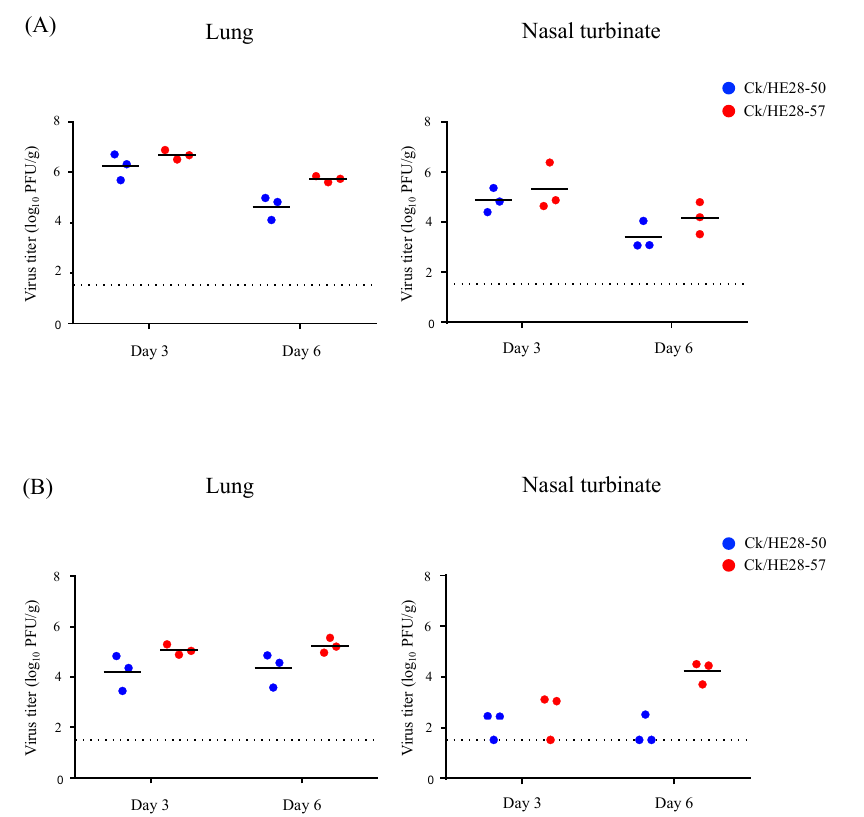
Figure 2. Virus titers in mice infected with H9N2 avian influenza viruses. Three mice per group were intranasally inoculated with ( A ) 10 6 PFU (in 50 µ L) or ( B ) 10 4 PFU (in 50 µ L) of Ck/HE28-50 or Ck/HE28-57. Lung and nasal turbinate tissues were collected from the infected mice at 3 and 6 days post-infection for virus titration. Each circle represents the virus titer of an individual sample. The bar indicates the mean and is shown only when the virus was recovered from all three mice. The lower limit of detection is indicated by the horizontal dashed line.